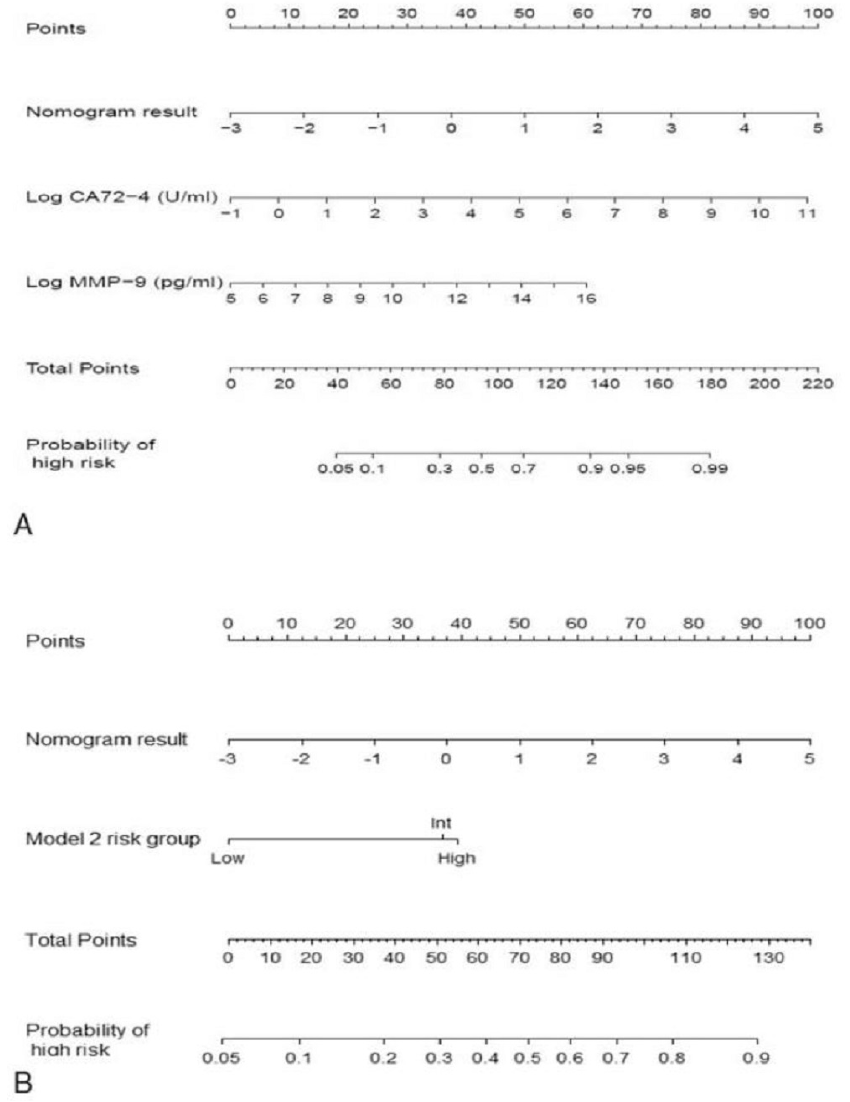
Figure 1. Clinical factors and cyst fluid analysis combined into a single nomogram for each model, based on factors MMP9 and CA 72-4 (part A ), and sFASL and IL-4 (part B ) [59]. This data was reprinted under the Creative Commons License.